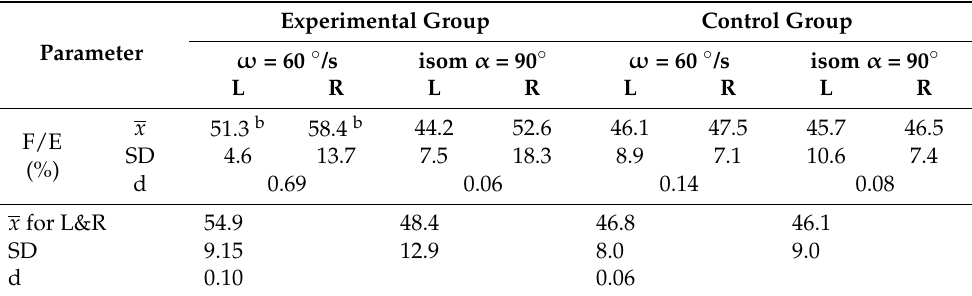
Table 3. Flexor/extensor ratio obtained from an isokinetic test with concentric movements ( ω = 60 °/s) and a static test ( α = 90°) (mean ± s).